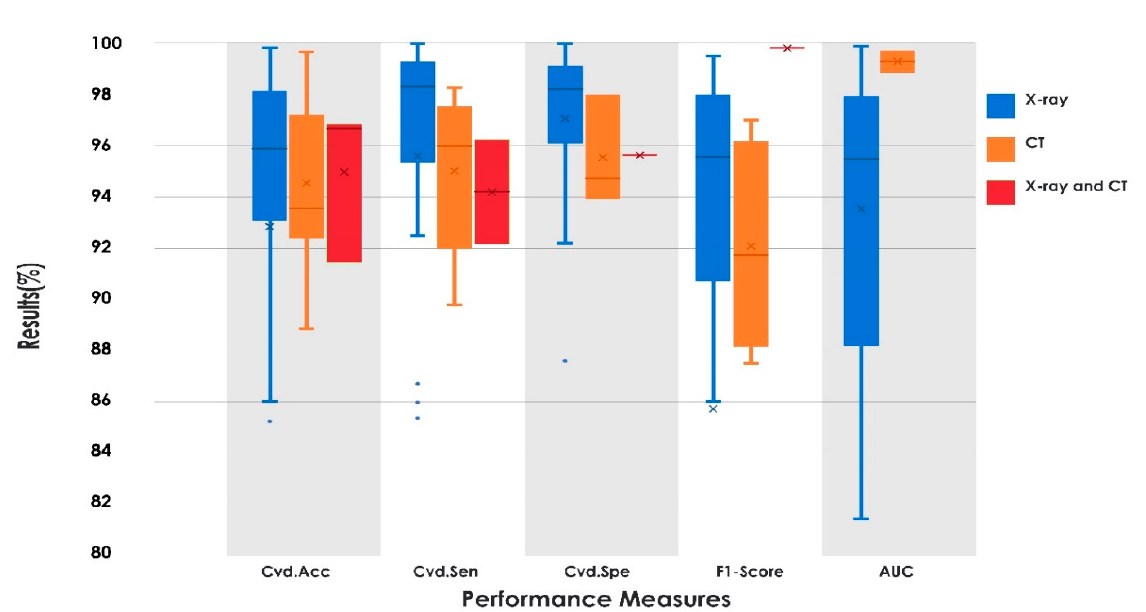
Figure 6. Comparison of Cvd.Acc, Cvd.Sen, Cvd.Spe, F1-Score, and AUC of AI techniques to detect COVID-19 using box plots.